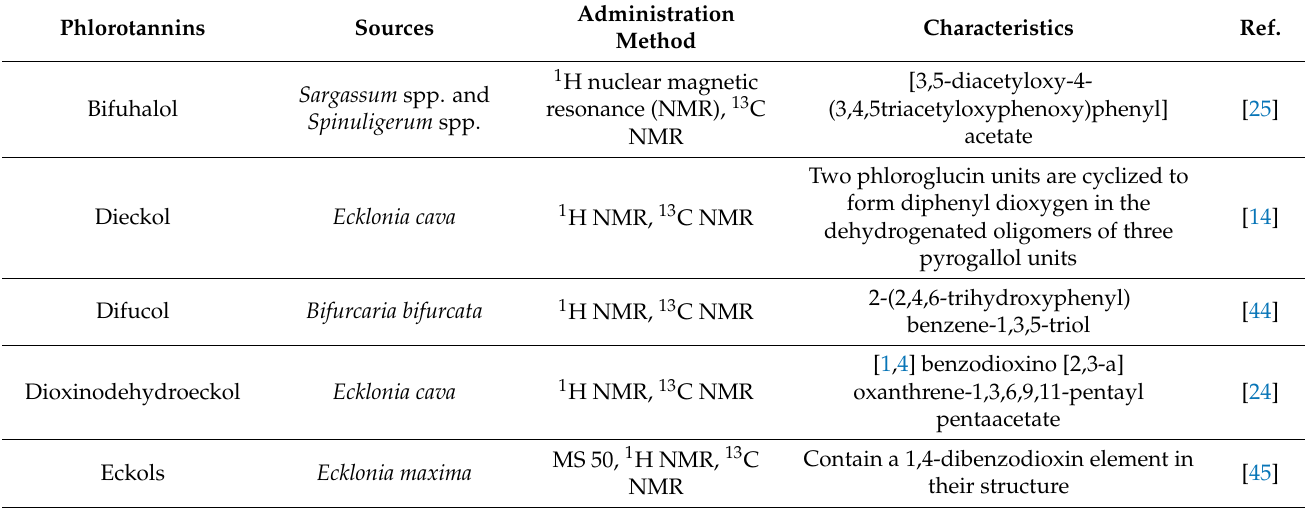
Table 1. Studies of characteristics and structure of phlorotannins extracted from brown seaweeds. Phlorotannins Sources Administration Method Characteristics Ref. Sargassum spp. and Bifuhalol Spinuligerum spp.